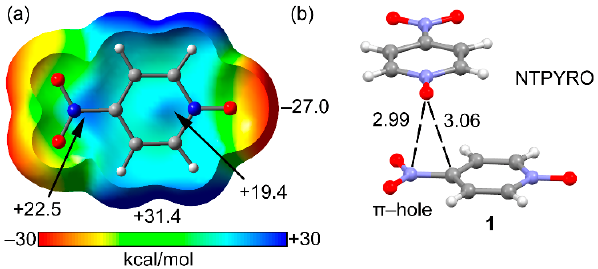
Figure 1. ( a ) Molecular Electrostatic Potential (MEP) surface (0.001 a.u.) of 1 . ( b ) X-ray solid state structures of 1 (NTPYRO). Distances in Å.